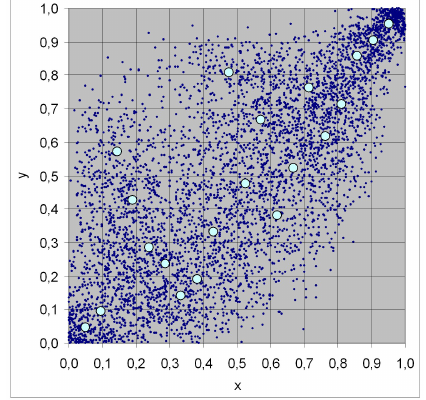
Figure 22: "Worst case" Poisson copula, a = b = 15